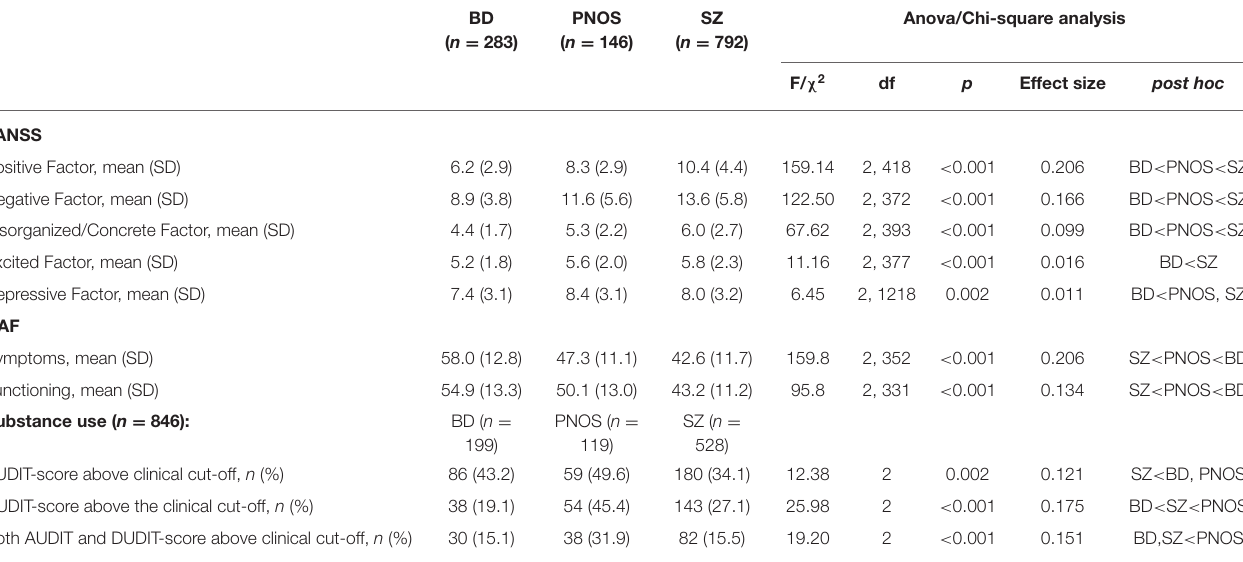
TABLE 3 | Clinical